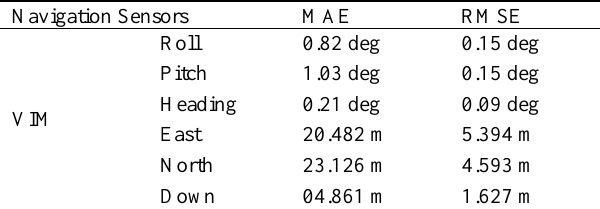
Table 4. The VIM navigation system accuracy Navigation Sensors